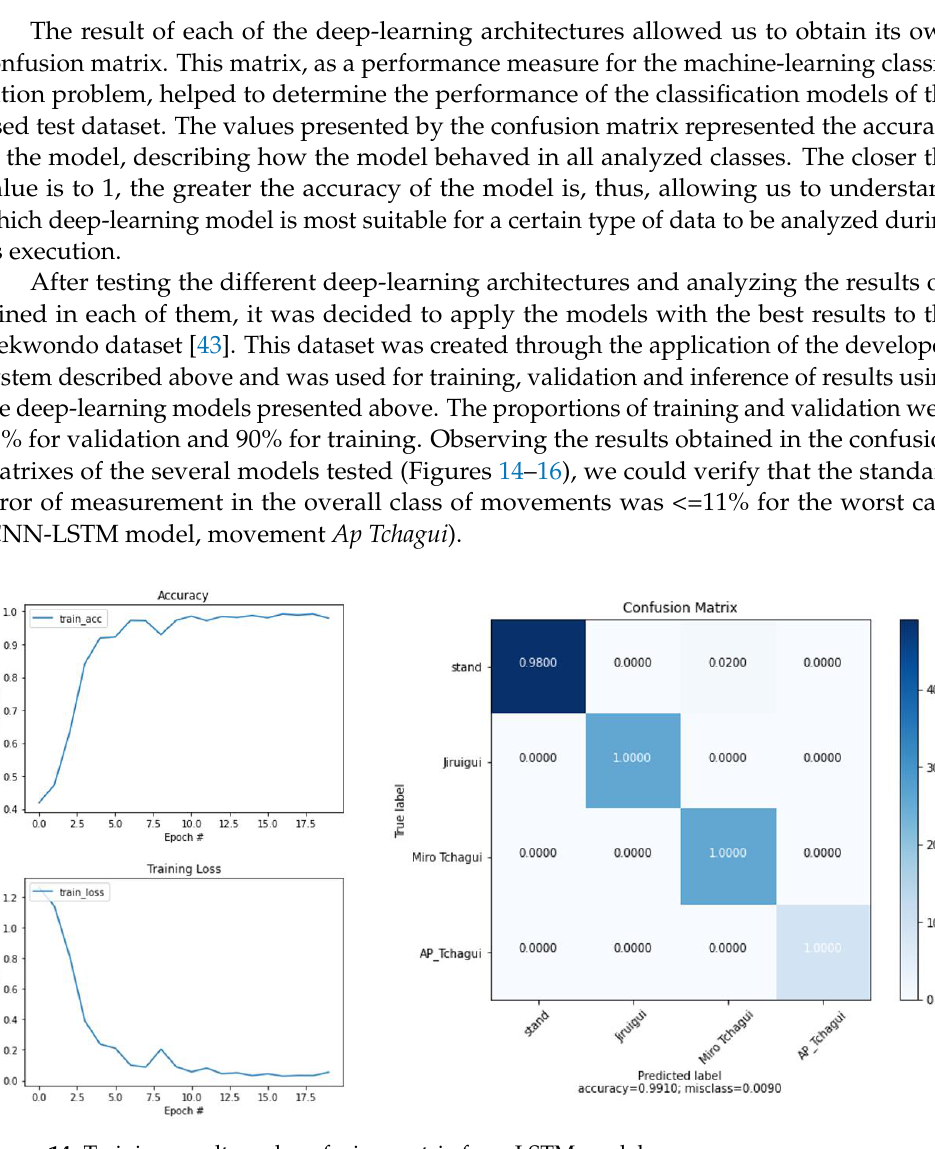
Figure 14. Training results and confusion matrix from LSTM model.